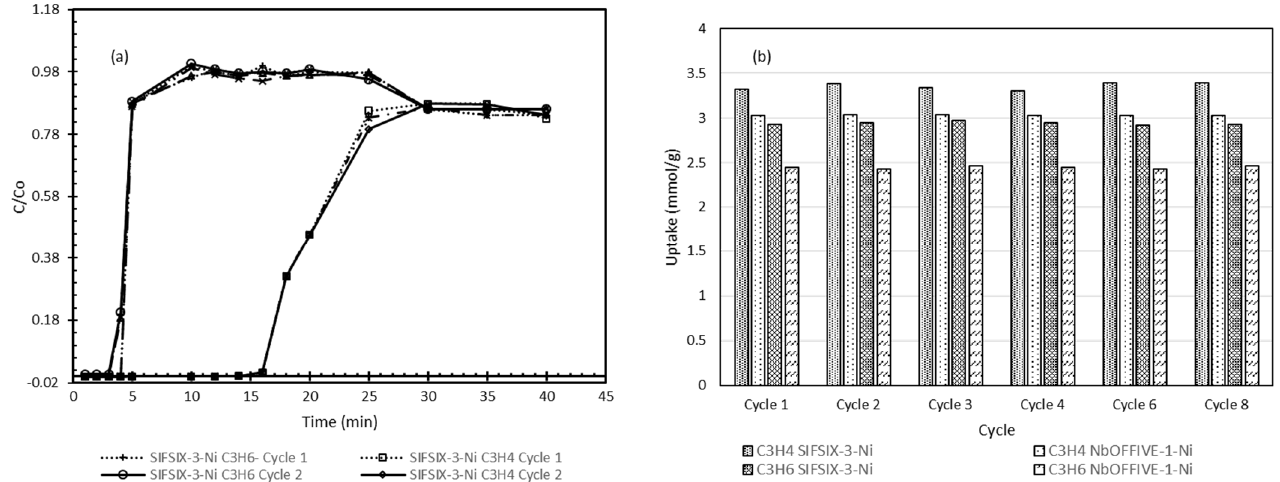
Figure 8. ( a ) Dynamic breakthrough curves for the SIFSIX and NbOFFIVE and C 3 H 4 /C 3 H 6 systems at 300 K (4 cycles are shown); ( b ) uptake amounts of C 3 H 4 /C 3 H 6 after 8 adsorption cycles at 300 K. Table 3. Modeling isotherm statistical parameters, isosteric heats of adsorption and micropores diffusion time constants for MOFs and C 3 H 4 / C 3 H 6 at 300 K.